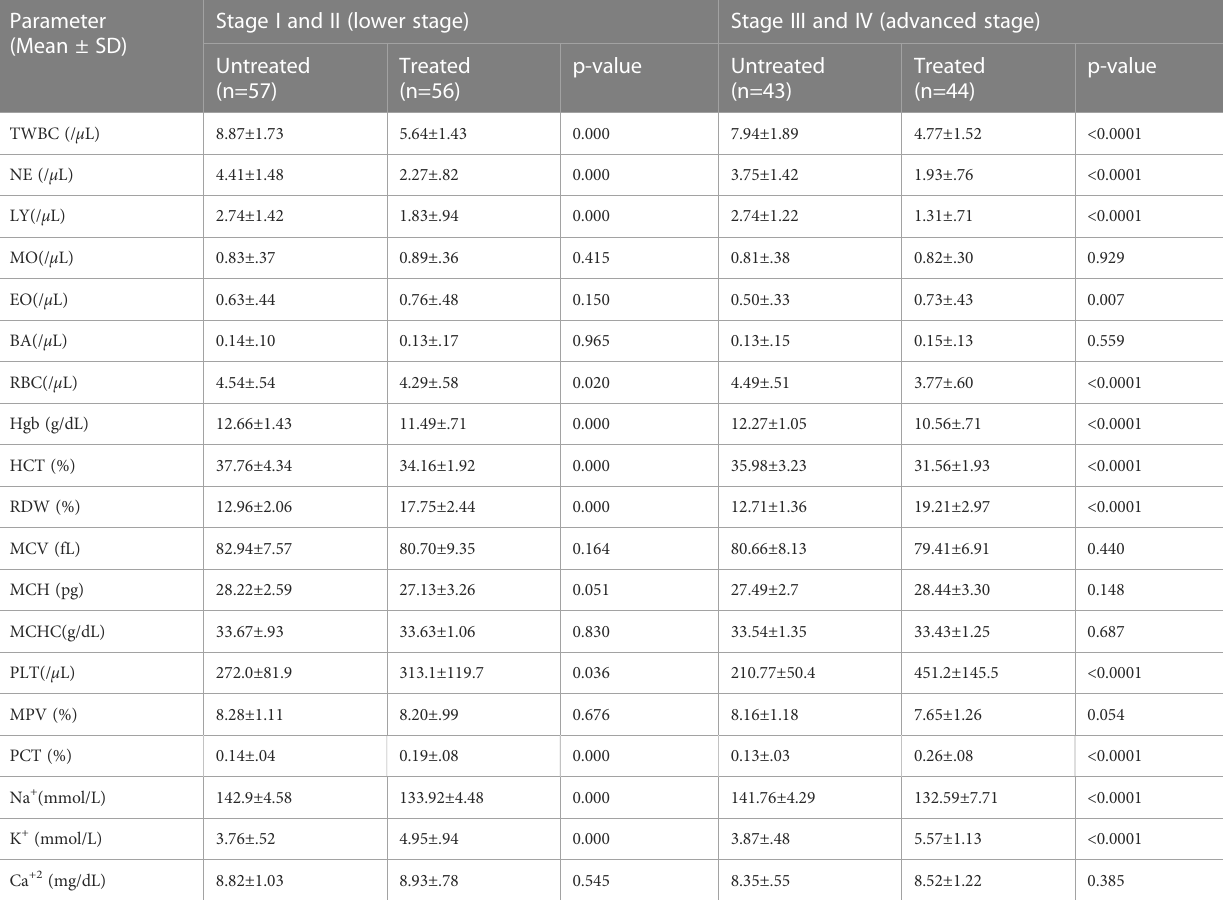
TABLE 4 Comparison of hematological and electrolyte parameters based on clinical stages. Parameter (Mean ±